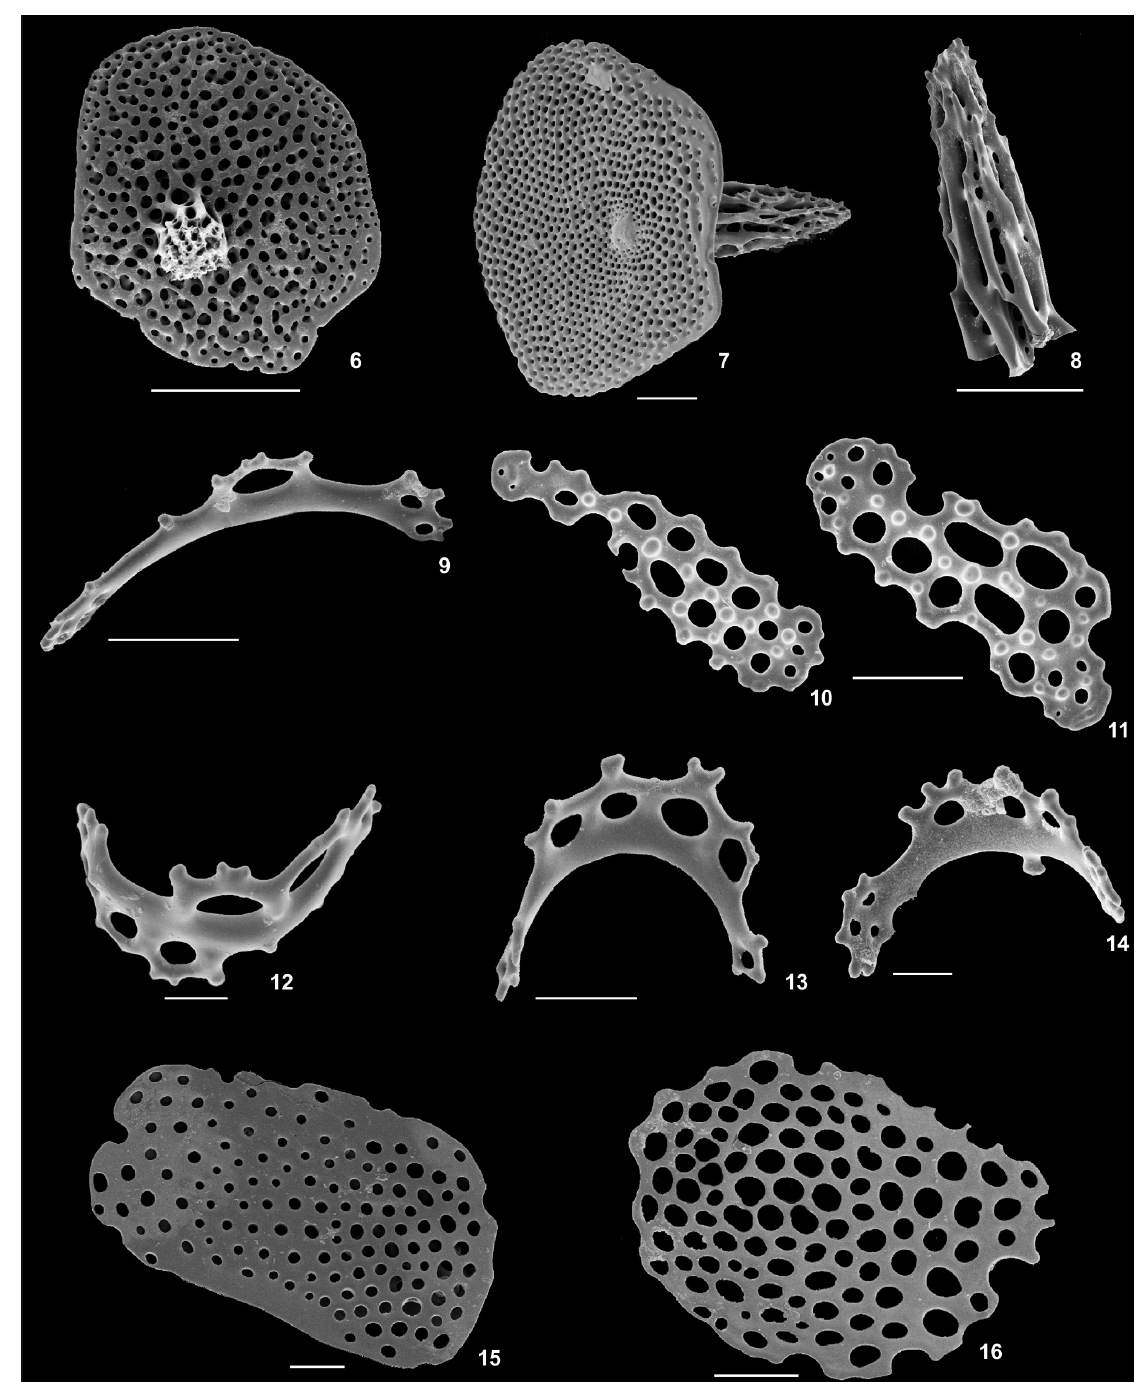
Figures 6–16. SEM photomicrographs of the ossicles from Ypsilothuria bitentaculata bitentaculata (MZUSP 1306). (6–7) tables from body wall in dorsal and lateral views, respectively; (8) detail of the spire; (9) rod from tentacles; (10–11) knobbed plates from introvert (12–14); arched rods from anal and oral siphon. (15–16) plates from oral and anal siphons, respectively. Scale bars: 6 = 500 μm, 7–8 = 200 μm, 9–11 = 50 μm, 12–16 = 20 μm. ZOOLOGIA 35: e24573 | DOI: 10.3897/zoologia.35.e24573 | March 9, 20184 /